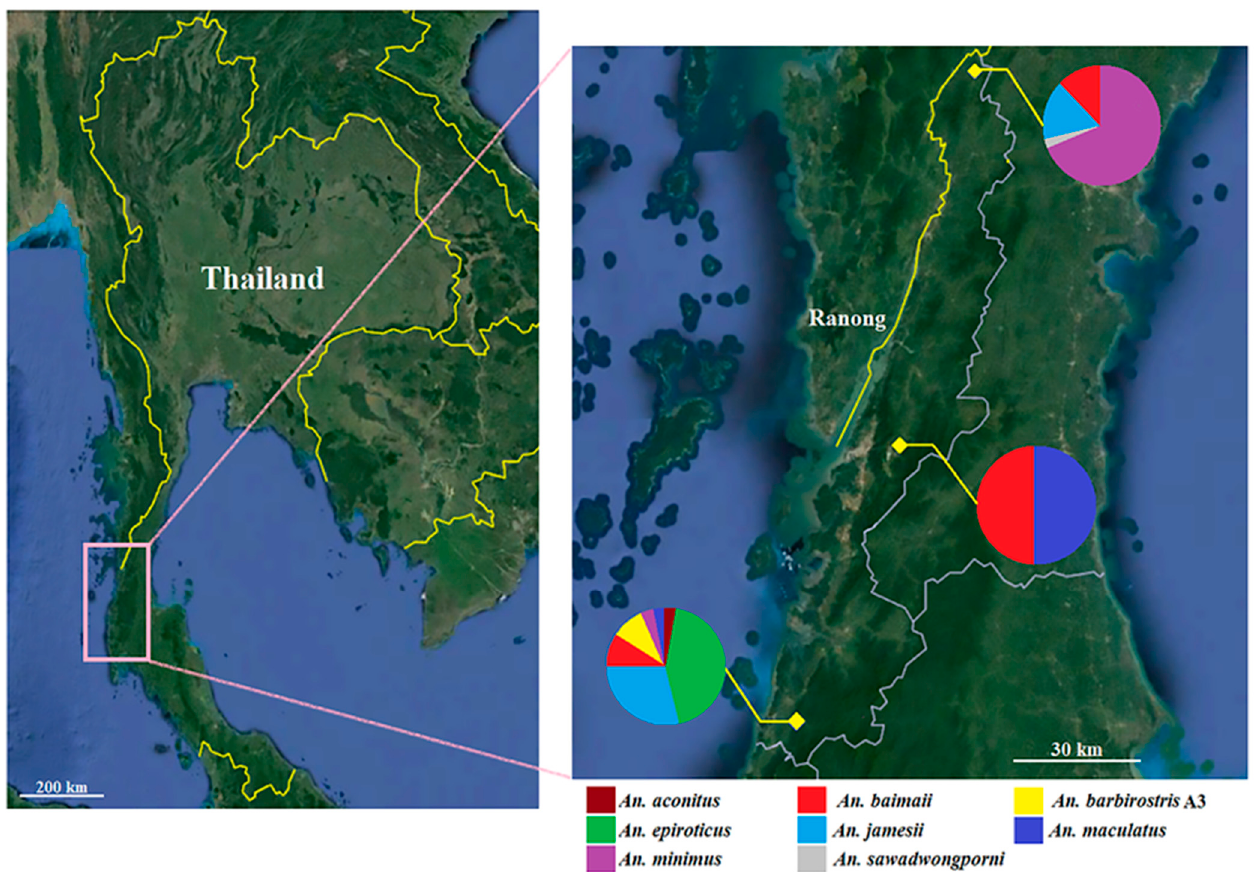
Figure 1. Map of study sites and diversity of Anopheles species in Ranong province, southern Thailand. Pie charts in this map show the frequency of each species in each location. This map was obtained from Google Earth Pro v 7.1.8 (https://earth.google.com (accessed on 10 October 202 2).